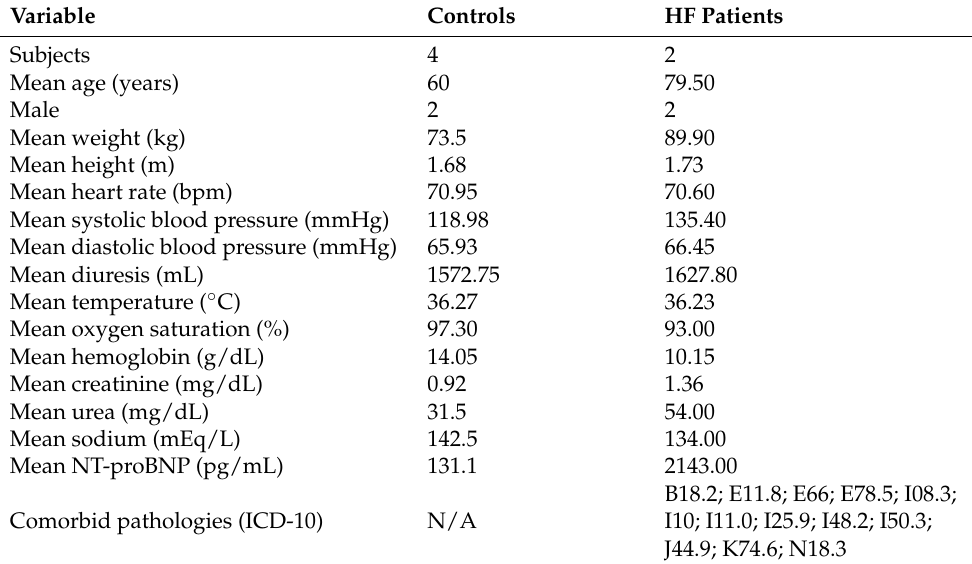
Table 1. Baseline characteristics of groups in the